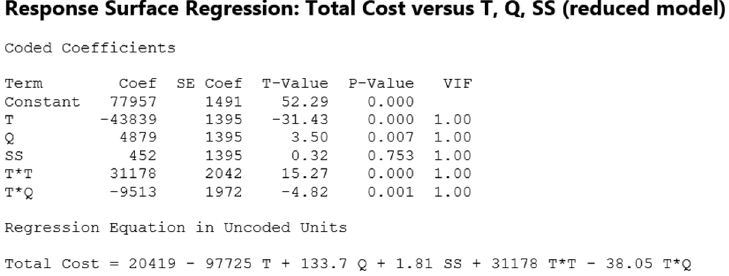
Figure 16. BBD—response surface regression of TC versus T, Q, and SS.